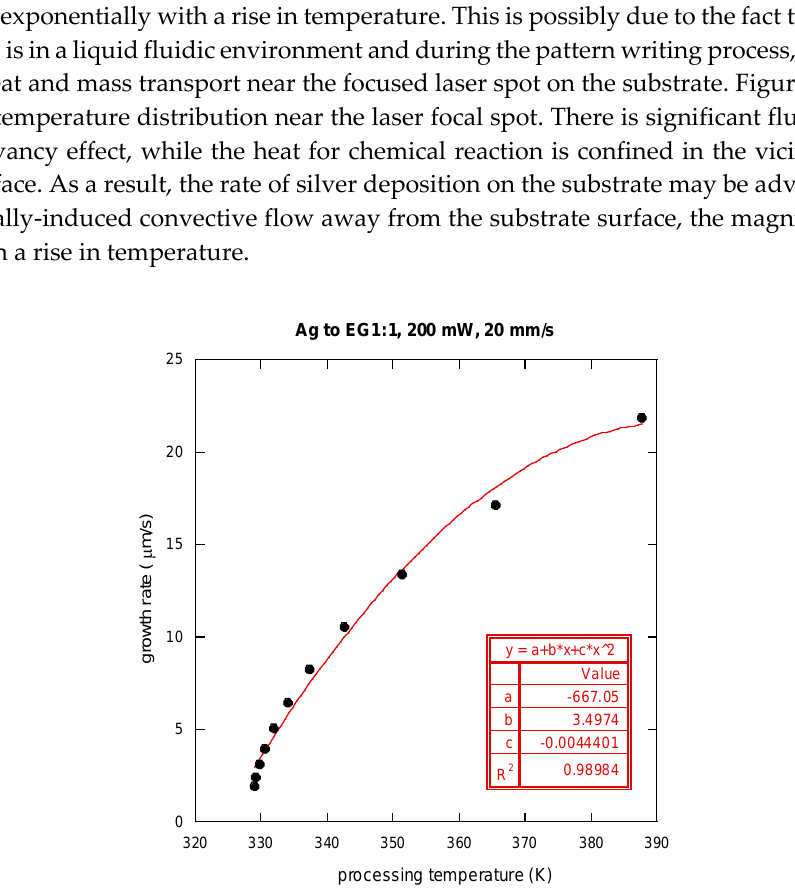
Figure 9. Variation of the silver line growth rate (in thickness) with respect to the processing temperature. The filled dots: the filled dots shown here were obtained using the fitted curve in Figure